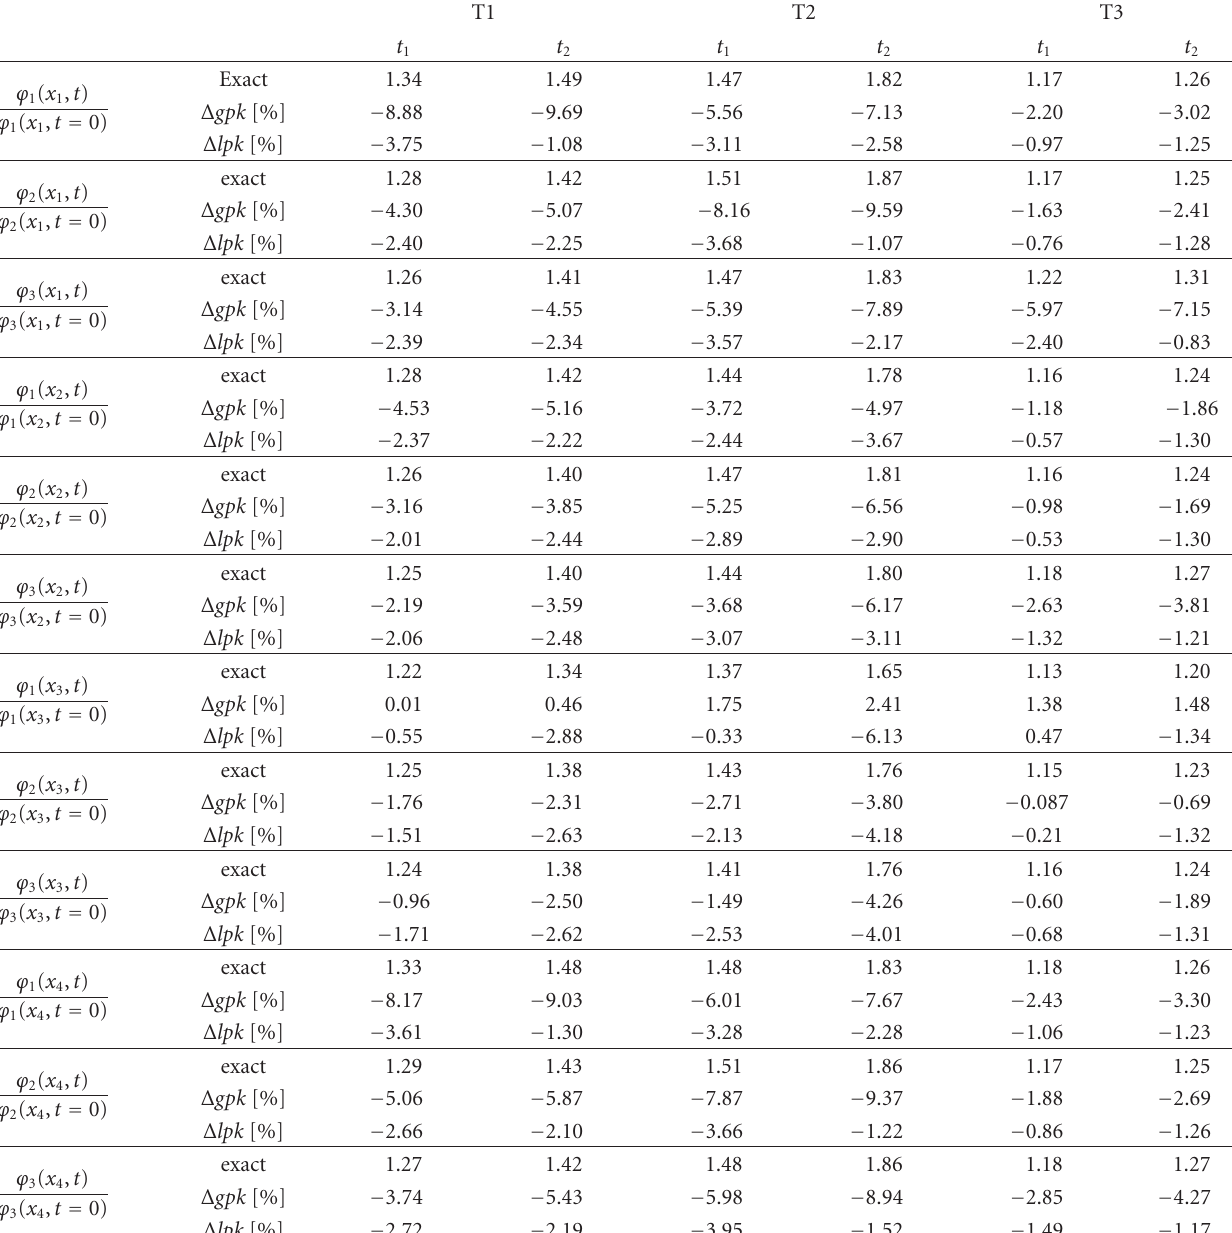
Table 3: Performance of gpk and lpk for the prediction of the flux in detectors located at x α (see positions in Figure 10(b)) during a transient induced by localized perturbations. Values of Δ ϕ are computed as relative percentage errors with respect to the corresponding reference values at two di ff erent time instants along the transient ( t 1 = 1ms and t 2 = 10ms). T1